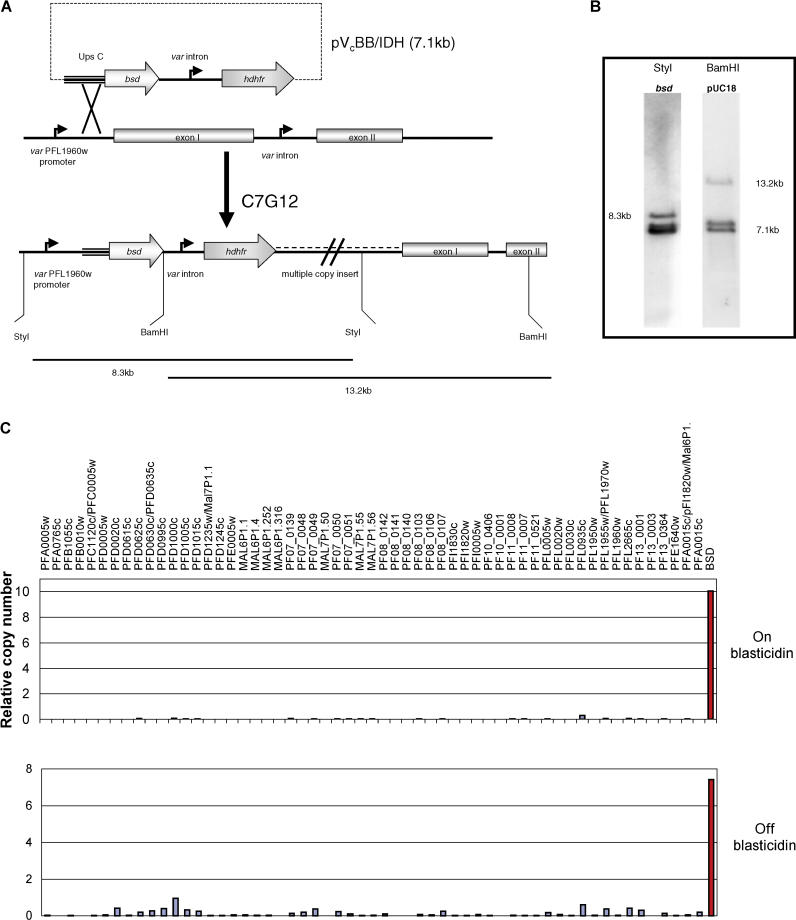
Integration of a bsd Expression Cassette into an Internal Chromosomal var Locus(A) Schematic diagram showing integration of the construct pVcBB/IDH into the var PFL1960w locus through a single homologous recombination event within the var upstream region.(B) Southern analysis was performed using BamHI and StyI digested gDNA hybridized with probes to bsd and pUC18. The 8.3-kb bsd band and the 13.2-kb pUC18 band correspond to the fragments flanking the integrated concatamer. The doublet at ~7.1 kb corresponds to fragments from within the integrated concatamer.(C) Analysis of the level of transcription of each var gene within the parasite genome shows that selection with blasticidin results in silencing of all members of the var gene family. The only var locus expressed by parasites grown under drug pressure (top panel) was the gene that contained the integrated bsd expressing plasmid. 10 wk after drug removal, the culture became transcriptionally heterogenous (bottom panel).